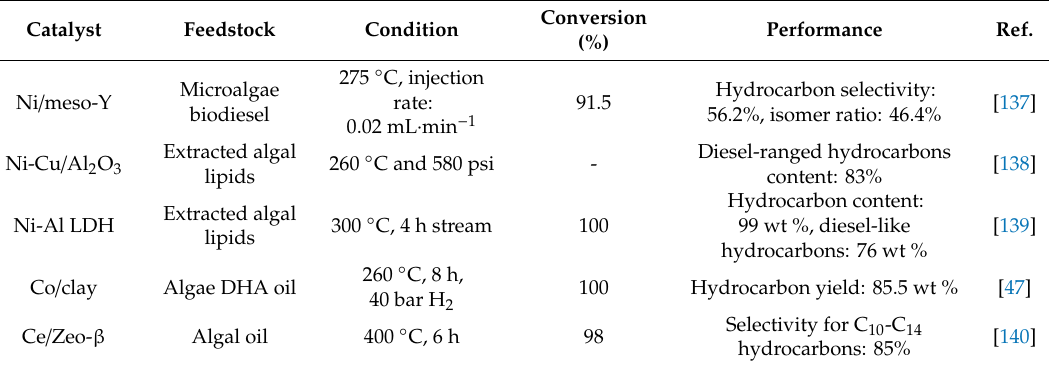
Table 6. Catalytic hydroprocessing of algal